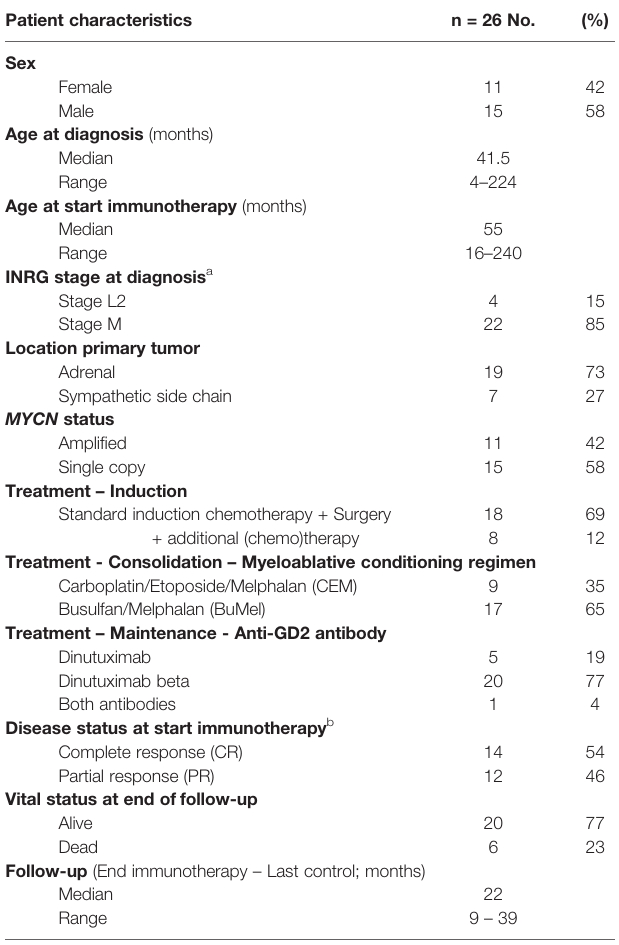
TABLE 2 | Patient characteristics of high-risk neuroblastoma